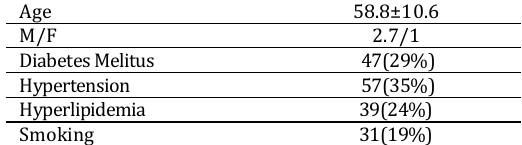
Table1. Demographic data of patients Age